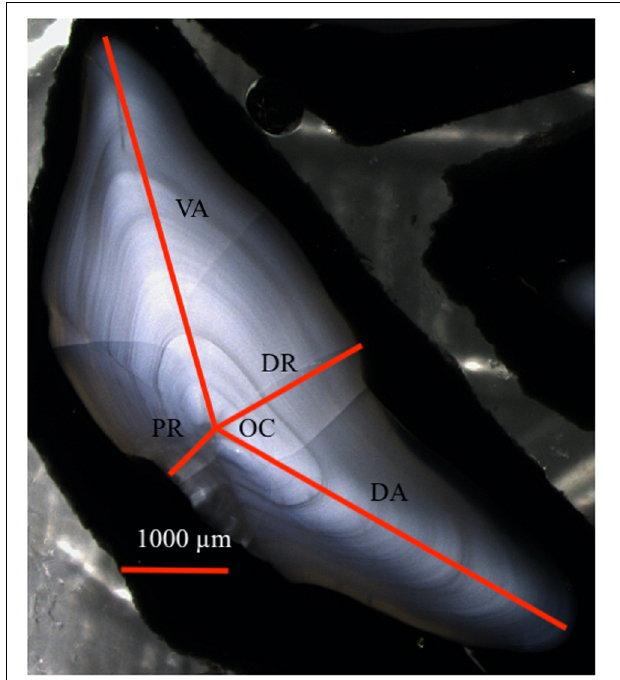
FIGURE 2 | The measured morphometry of the otolith. OC – otolith core, DA – dorsal axis, VA – ventral axis, DR – distal radius, PR – proximal radius.